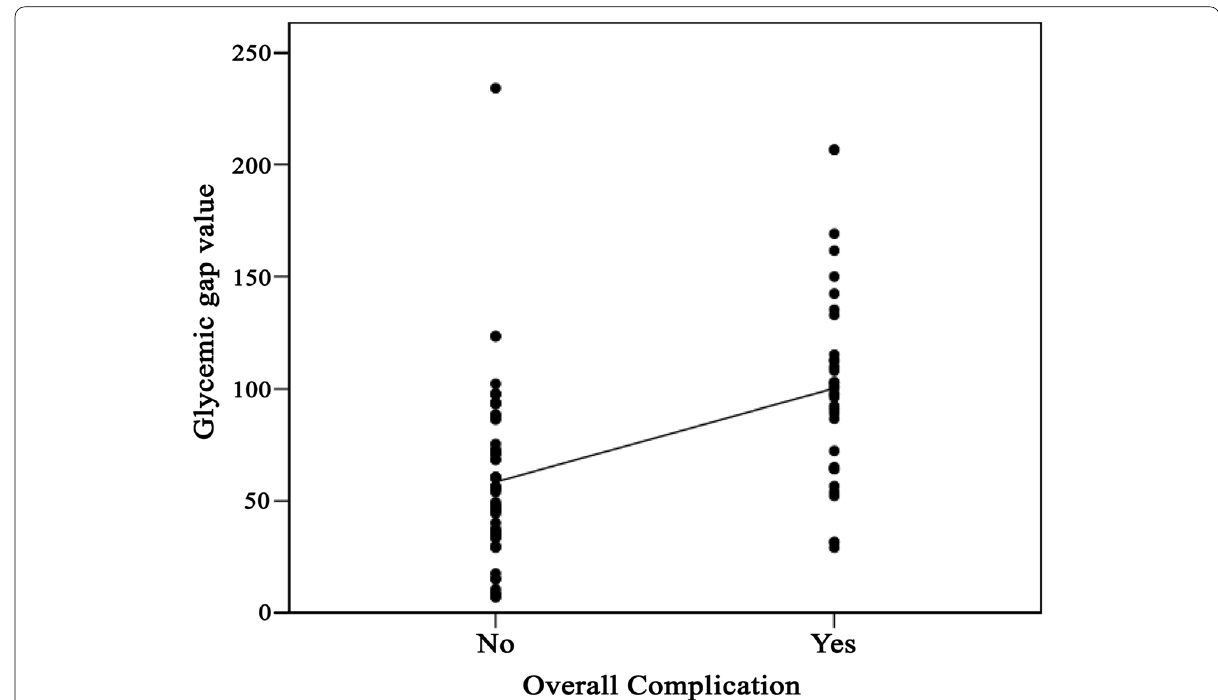
Fig. 1 Correlation between MACE occurrence and glycemic gap value ( n